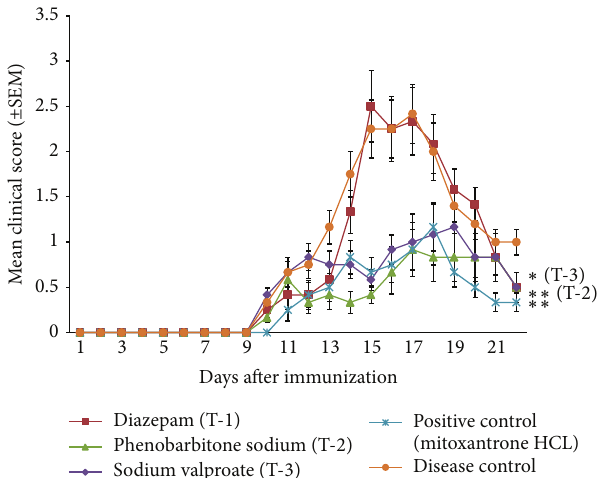
Figure 1: Changes in neurological/clinical signs of EAE with days after immunization. Significant difference was found in the mean clinical scores ( ± SEM), [ 𝑛 = 6 ] of animals of phenobarbitone (T- 2) and sodium valproate (T-3) groups as compared to the diseased control group, [ ∗ 𝑃 ≤ 0.05 by one way ANOVA (Dunnett’s multiple comparisons test)].